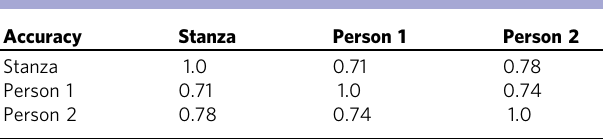
Table 1 Accuracy of Stanza.